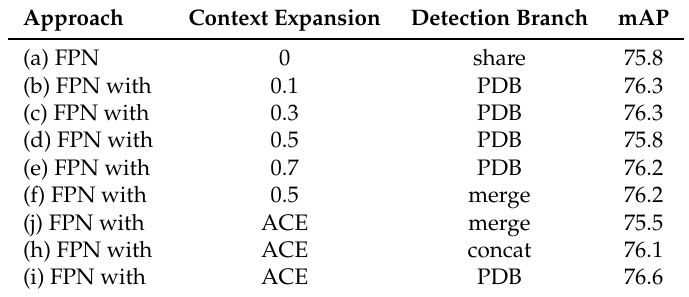
Table 2. Ablation study of the proposed ACE and PDB in adaptive parallel detection subnet on